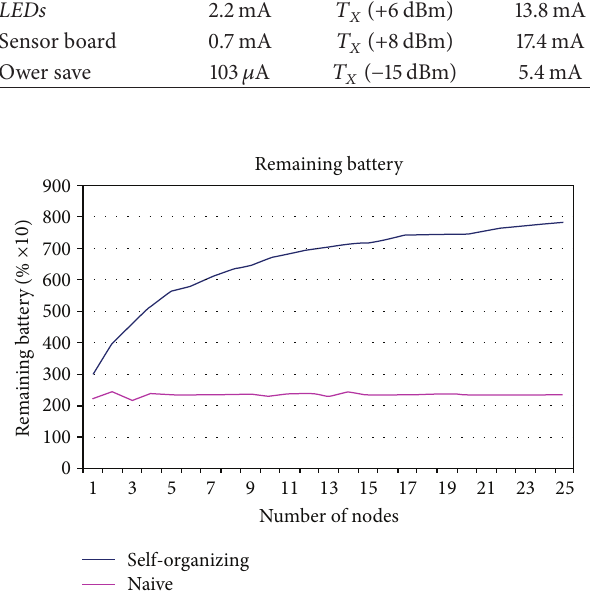
Figure 6: Battery consumption while sampling a spatiotemporal signal.